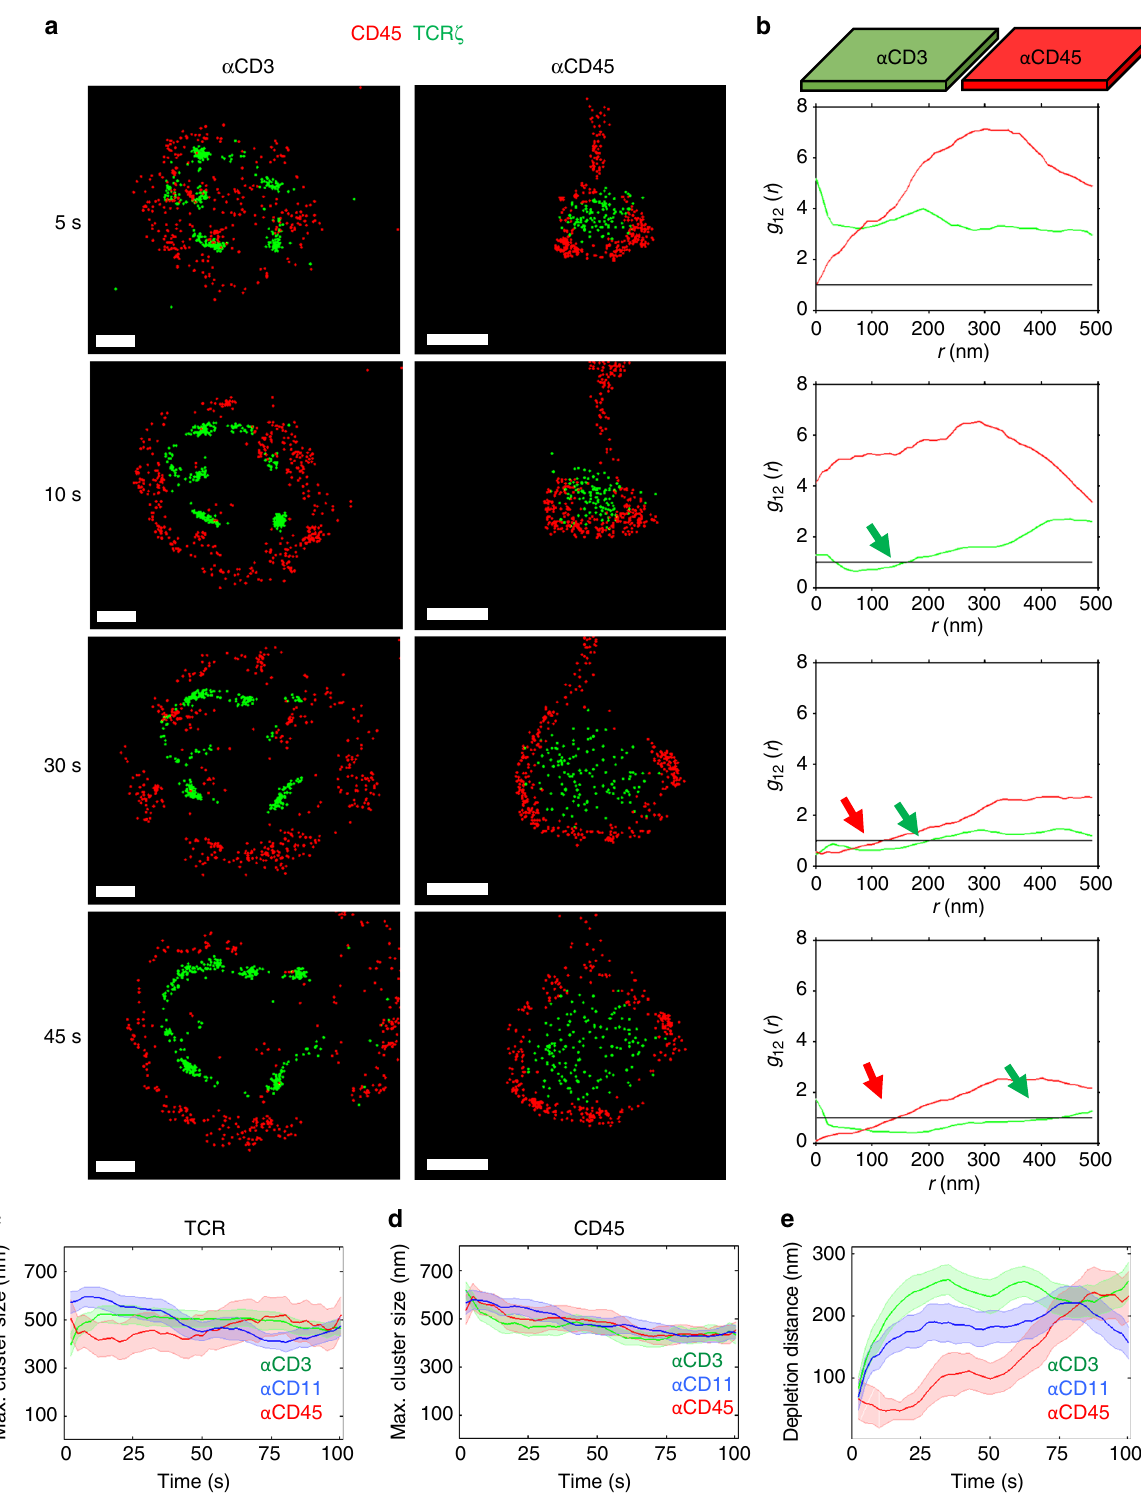
Fig. 2 The evolution of a depletion zone and its dynamics under multiple conditions. a Zooming to new forming regions. Time sequence of the synapse formed at distinct areas in between Jurkat cells expressing CD3 ζ -Dronpa (green) and immunostained for CD45 with Alexa647 (red) and modi fi ed coverslips, anti-CD3 (left) and anti-CD45 (right) at different time samples of 5, 10, 30 and 45 s after the cell started to spread. Scale bar 0.5 μ m. b The PCF between TCR and CD45 molecules captured from the areas shown in a of cell spread over anti-CD3 (green lines) and anti-CD45 (red lines) modi fi ed coverslips. Arrows point to the crossing of the PCF with the value of one. The position of where the PCF is crossing the value of one de fi ne the: (1) maximal TCR cluster size c , (2) the maximal CD45 cluster size d and (3) the depletion distance e in the cases of PCF calculated between (1) TCR and TCR ( g 11 ), (2) CD45 and CD45 ( g 22 ), (3) TCR and CD45 ( g 12 ) molecules respectively. Plots shown are for PCF calculated for areas of cells spread over anti-CD3 (green, n = 38), anti-CD45 (red, n = 16) and anti-CD11 (blue, n =